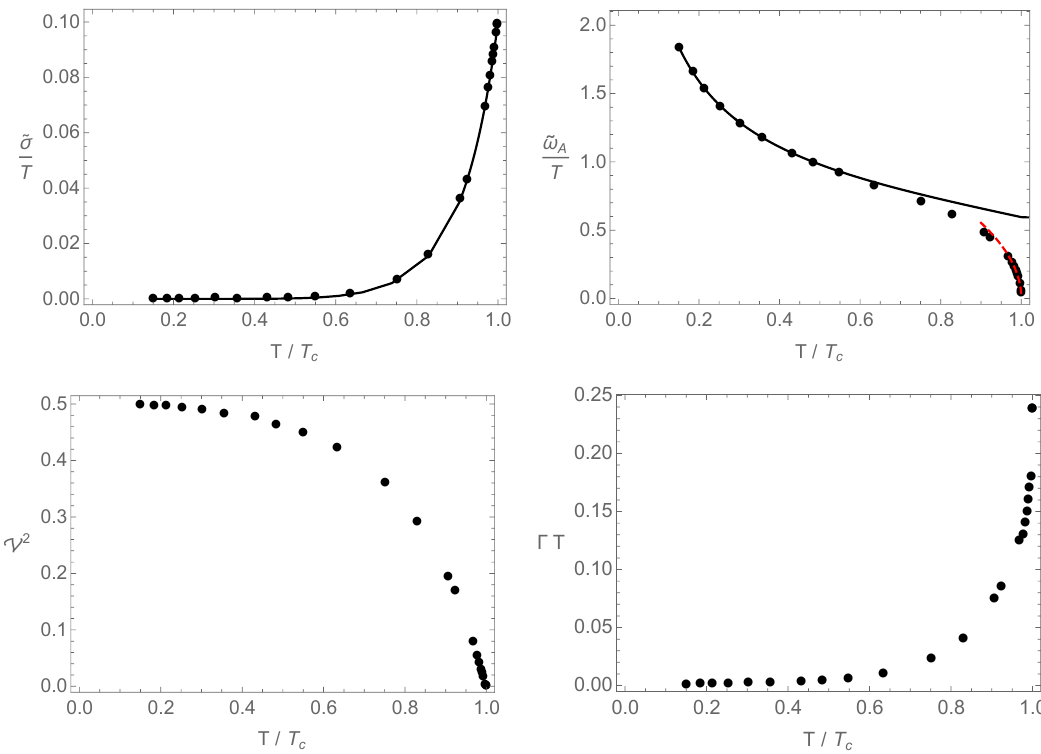
Figure 12 . Coefficients appearing in the dispersion relation, eq. (6.2). Solid black lines are drawn using eq. (5.9) for ˜ σ and eq. (5.11) for ˜ ω . The red dashed line near T is eq. (5.12). The speed A c of propagation V and the attenuation constant Γ coincide exactly with those reported for second sound in the holographic superfluid